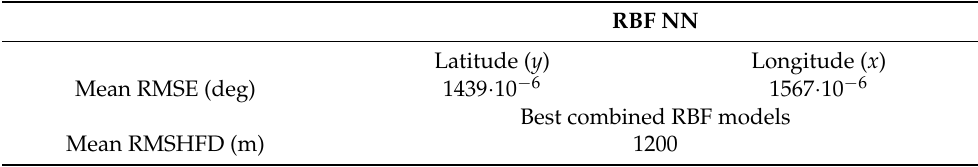
Table 1. Performance metrics of the produced RBF NN